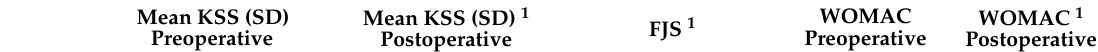
Table 3. Revisions, ROM, clinical